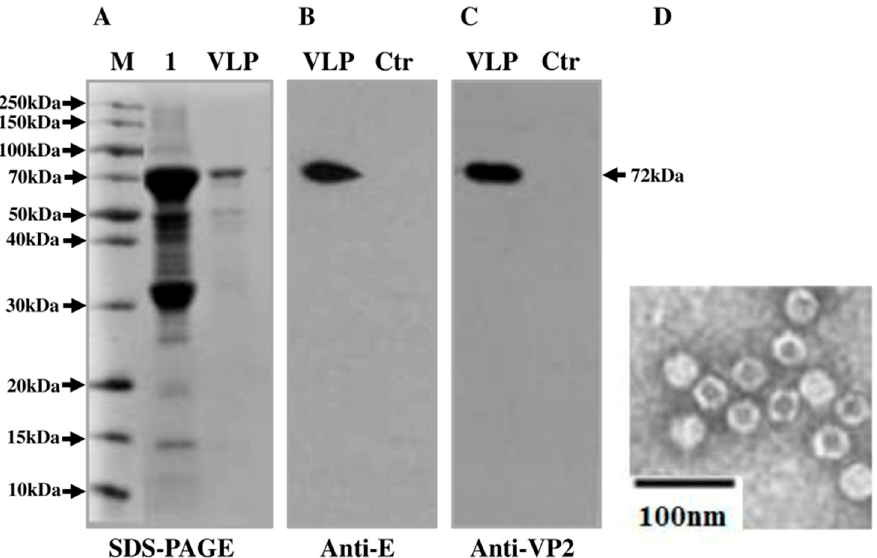
Figure 2. Expression, purification, and characterization of VLP-JEVe. ( A ), SDS-PAGE analysis of the expression of VLP-JEVe in E.coli . M: protein marker; lane 1: VLP-JEVe induced with IPTG; lane 2: purified VLP-JEVe. ( B , C ), Western-blot analysis of purified VLP-JEVe and control with anti-JEV E and anti-PPV VP2 antibody. ( D ), The purified VLP-JEVe was processed for negative staining and observed with an electron microscope.